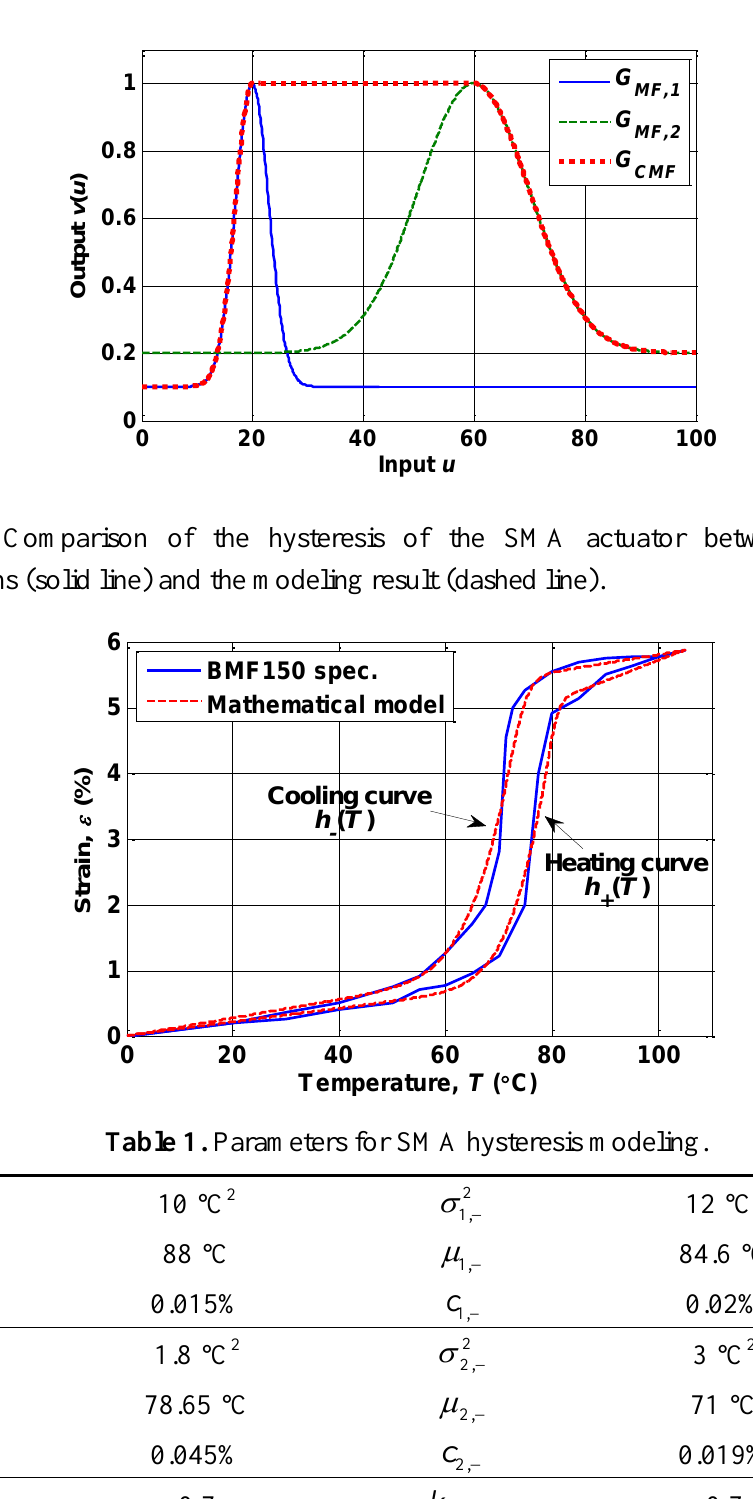
(solid line) and G (dashed line). MF,1 MF,2